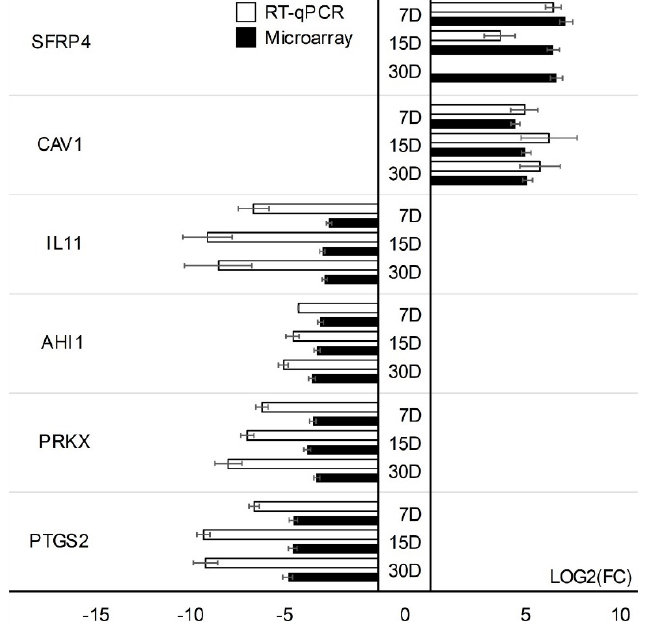
Figure 6. RT − qPCR evaluation of selected genes based upon the microarray data (log(FC)) in GCs. Validation of the microarray method was performed in three separate biological repetitions. Each of the biological repetitions was performed in three technical repetitions; D: day of culture; FC: fold change.